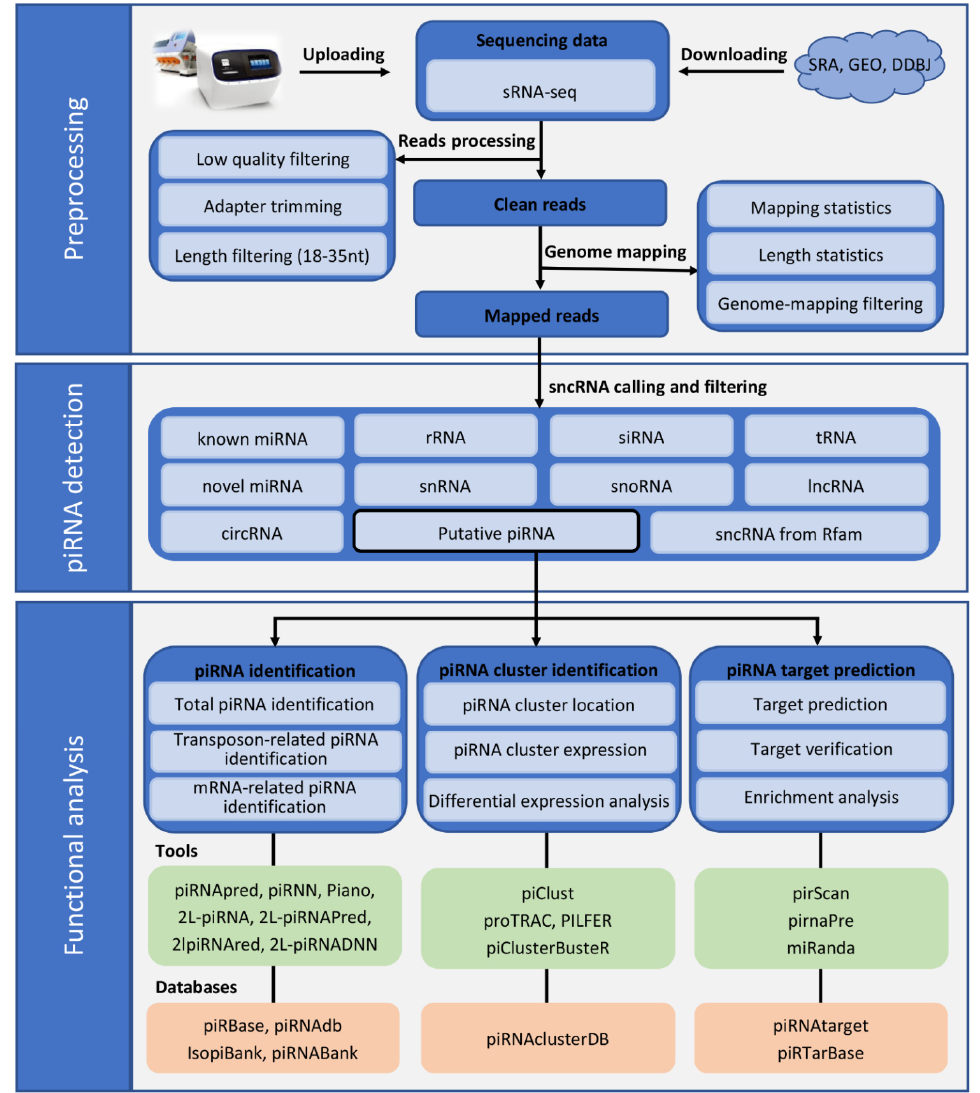
Figure 1. Overview of common pipeline for PIWI-interacting RNA (piRNA) discovery and functional analysis in metazoans. The raw data of small RNA sequencing (sRNA-seq) were trimmed using adapters, quality control was performed, and the data were subsequently filtered by read lengths. Generally, microRNAs (miRNAs) and small interfering RNAs (siRNAs) are 20–25 nt in length, transfer RNAs (tRNAs) are typically ~80 nt in length, and small nuclear RNAs (snRNAs) and circular RNAs (circRNAs) are more than 100 nt in length, whereas piRNAs normally have lengths of 24–31 nt. However, species-specific piRNAs of 21 nt with a 5 ′ uridine (21U-RNAs) binding to p53-responsive gene 1 (PRG-1) and 22 nt piRNAs with a 5 ′ guanosine (22G-RNAs) loaded onto worm-specific Argonautes (WAGOs) were detected in C. elegans [50–52]. In the preprocessing step, the potential piRNAs and piRNA isoforms with a length of 18–35 nt were preserved for subsequent known RNA mapping and filtration. The remaining putative piRNA reads were processed for piRNA analysis using multiple tools and databases.